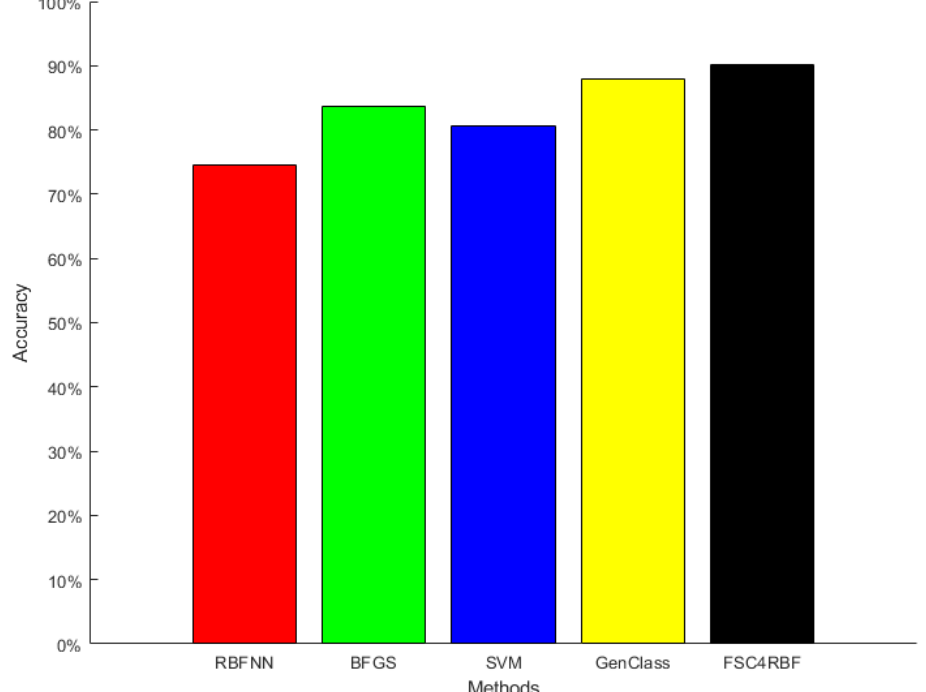
Figure 4. Comparison results plot. This figure visualizes the classification accuracy between the proposed FSC4RBF algorithm and four existing methods. It is shown that the proposed method managed to achieve the highest accuracy (black bar) in the custom-created